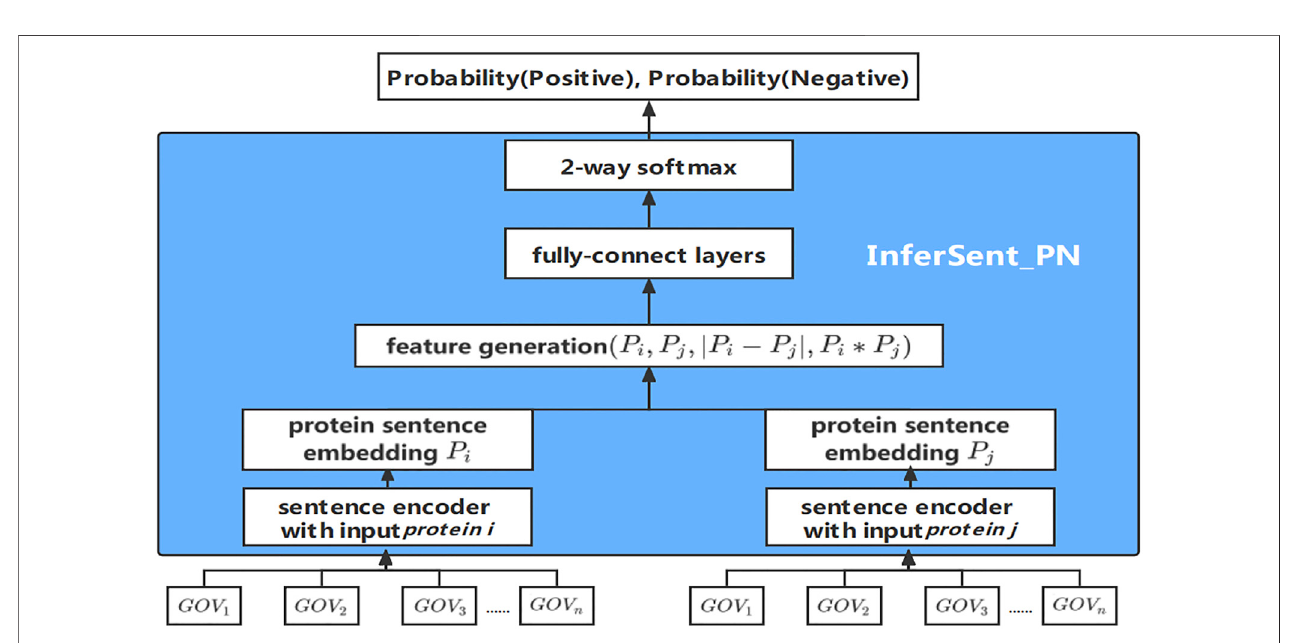
FIGURE 4 | The work fl ow of the InferSent_PN model.